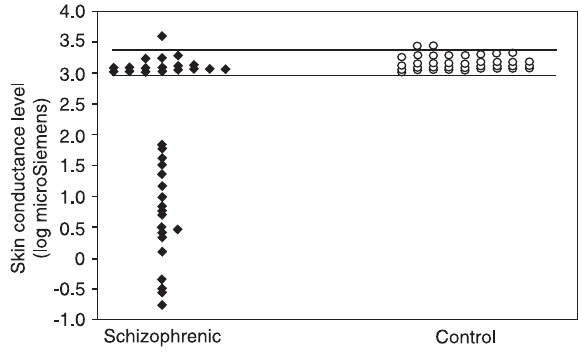
Table 3. Demographic, clinical, and electrodermal conductance characteristics of subjects grouped according to basal skin conduc- tance level.